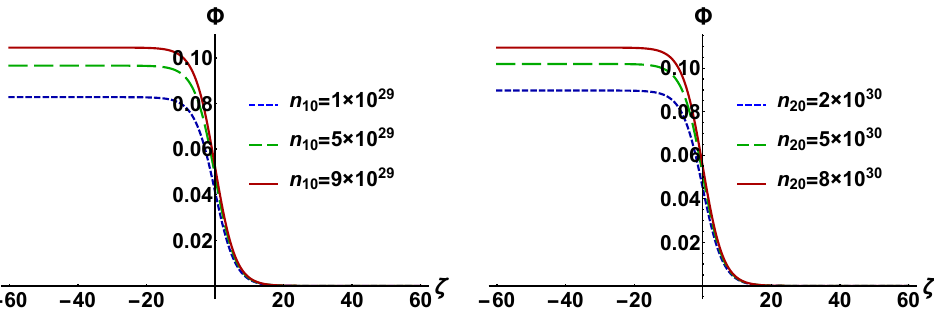
Figure 4. Plot of Φ vs. ζ for different values of n 10 ( left panel ) and for different values of n 20 ( right panel ) when α = 5/3, δ = 20 ◦ , η = 0.3, γ e = 4/3, Z 1 = 37, Z 2 = 6, n 10 = 10 29 cm − 3 , = 10 33 cm − 3 , U = 0.05, and v p = v p + n 20 = 10 30 cm − 3 , n e 0 0